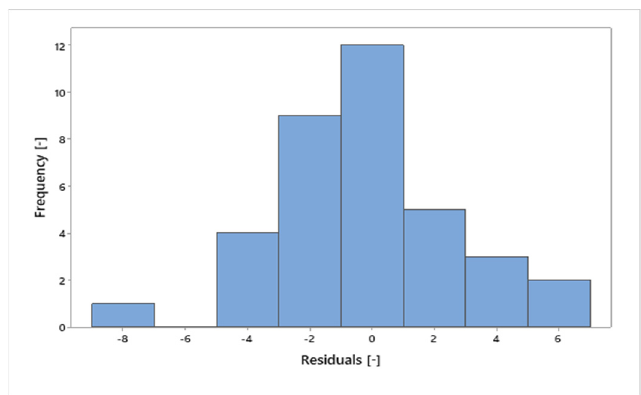
Figure 16. Frequency x residuals for the statistical analysis of gravimetric data of MHSW in the city of Belém-Pará-Brazil on 18 October 2021, 20 October 2021, 27 October 2021, and 29 October 2021.